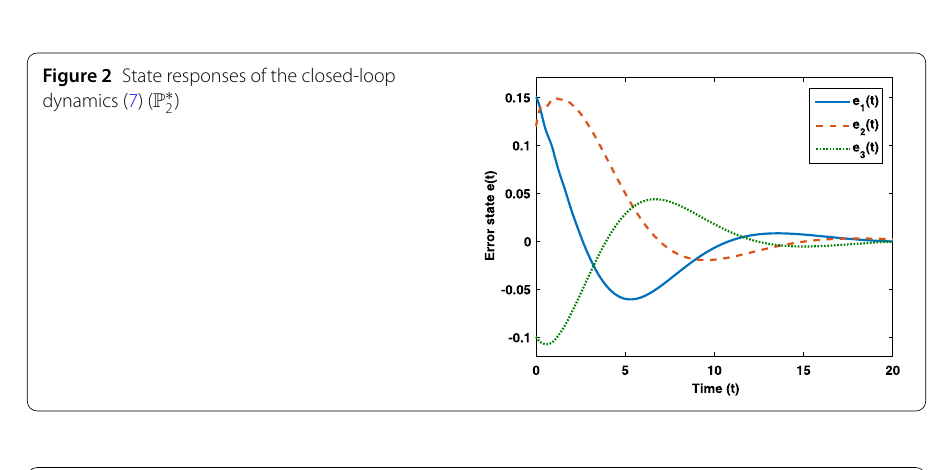
Figure 3 State responses of the closed-loop dynamics (25) ( P ∗ 1